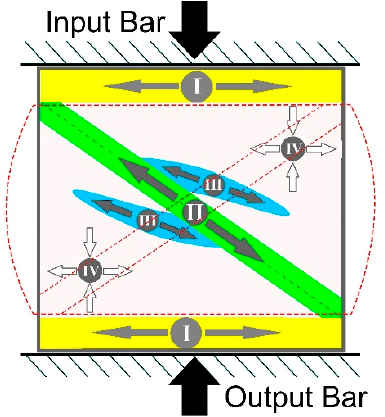
Figure 8. Schematic map of the location of the different zones in the longitudinal section of the test cylindrical samples. Roman numbers denote a certain zone. Black arrows indicate the direction of compression force.